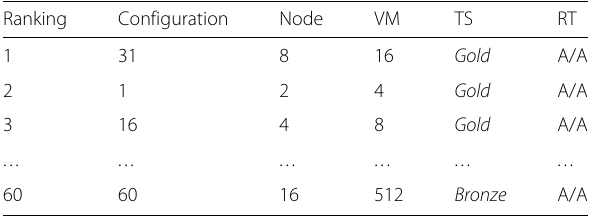
Table 17 Summary of the components used to rank the configurations (Third Case) Ranking